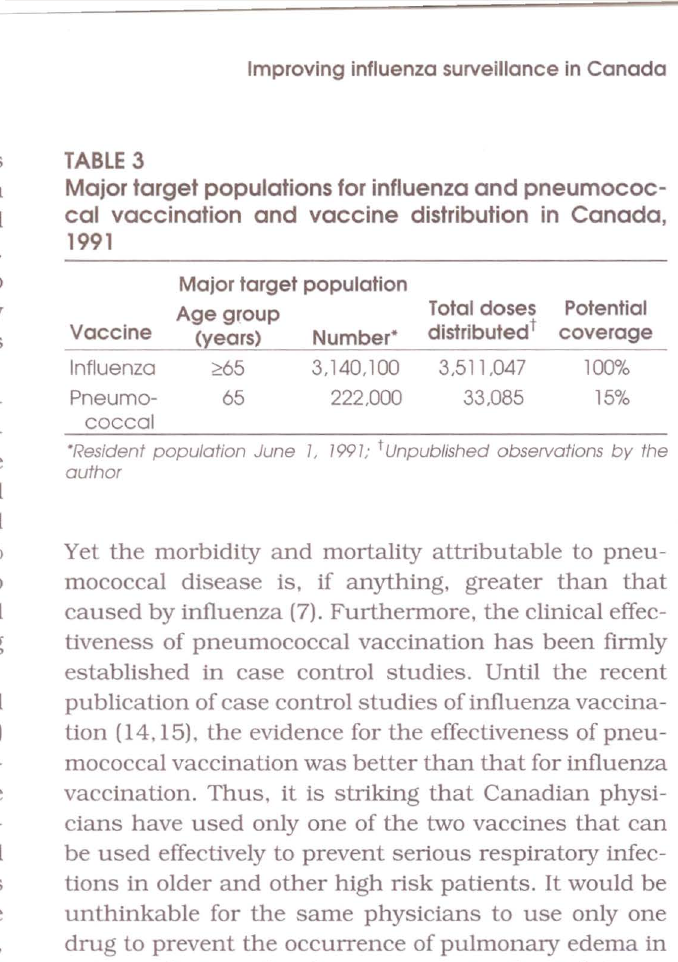
Major target populations for influenza and pneumococ cal vaccination and vaccine distribution in